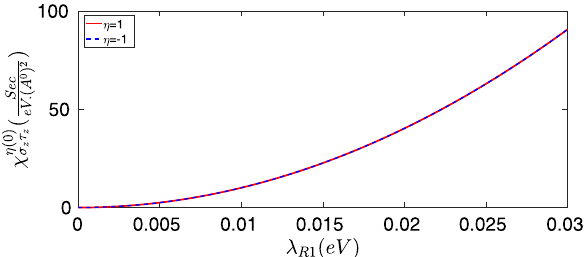
Figure 2. Spin to pseudo-spin bare response function of pure graphene in terms of the extrinsic Rashba 0.08 ( eV ) coupling strength for E F =